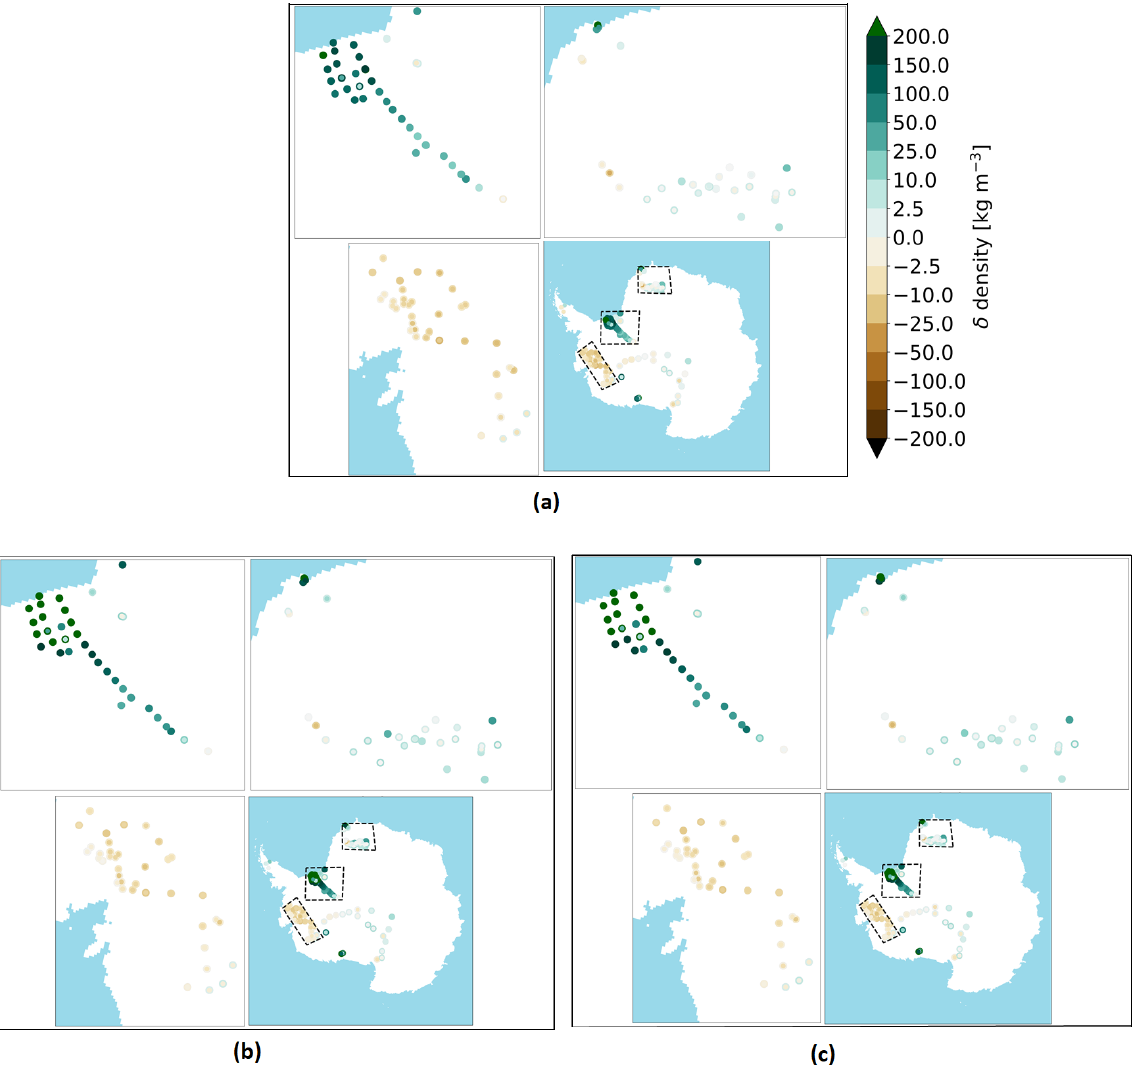
Figure 5. The density bias between simulations and the observations (model minus core). The outer ring represents densities less than 550kgm − 3 , and the inner circle represents densities greater than 550kgm − 3 . Panel (a) is the Fixed model, (b) is Dyn03, and (c) is Dyn15. Each panel shows the entire AIS with three dashed black boxes. Each box outlines a zoom-in area: from east to west the Dronning Maud Land, Filchner–Ronne ice shelf, and Marie Byrd Land. All panels have the same colour